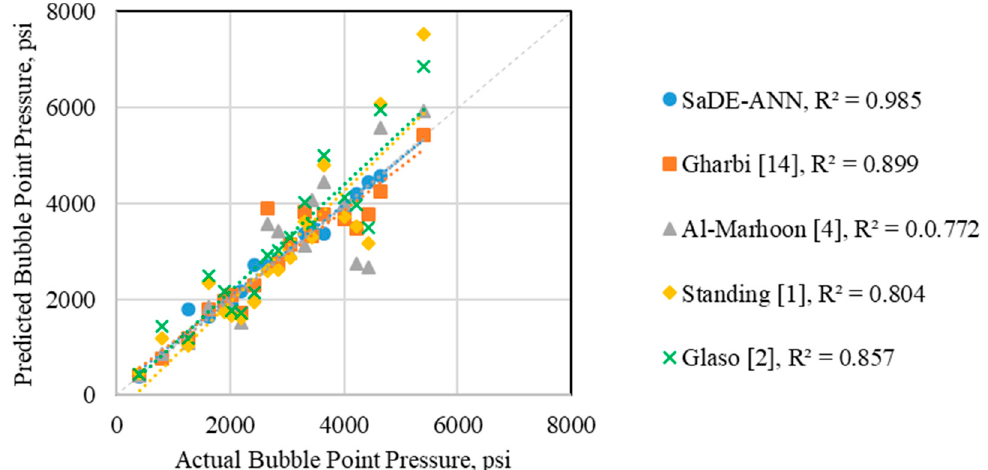
Figure 3 . Validation cross plot comparison of bubble point pressure prediction achieved using different models. The SaDE-ANN model achieved the best match compared to other correlations.